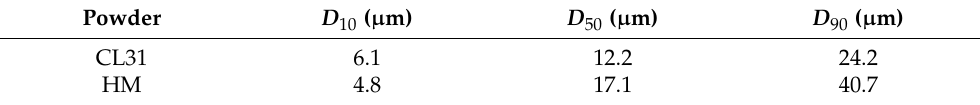
Table 2. Particle size percentile values of the powders, derived from the number cumulative